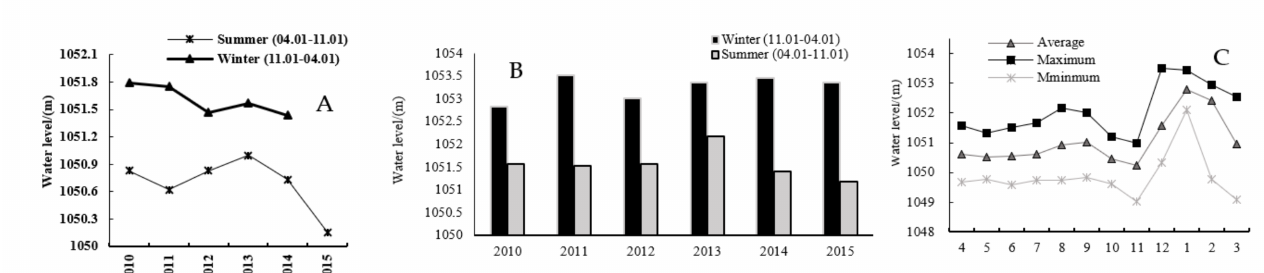
Figure 4. The intra- and inter-annual hydrological regime changes at the Bayanganle water stations. ( A ) Yearly average winter and summer water levels at the Bayangaole water station from 2010 to 2015. Winter was defined as November 1 to April 1 of the following year each year; summer was defined as April 1 to November 1 each study year. ( B ) Yearly maximum winter and summer water level at the Bayangaole water station from 2010 to 2015. Winter was defined as November 1 to April 1 of the following year each year; summer was defined as April 1 to November 1 each study year. ( C ) Monthly average, maximum and minimum water levels at the Bayangaole water station from 2010 to